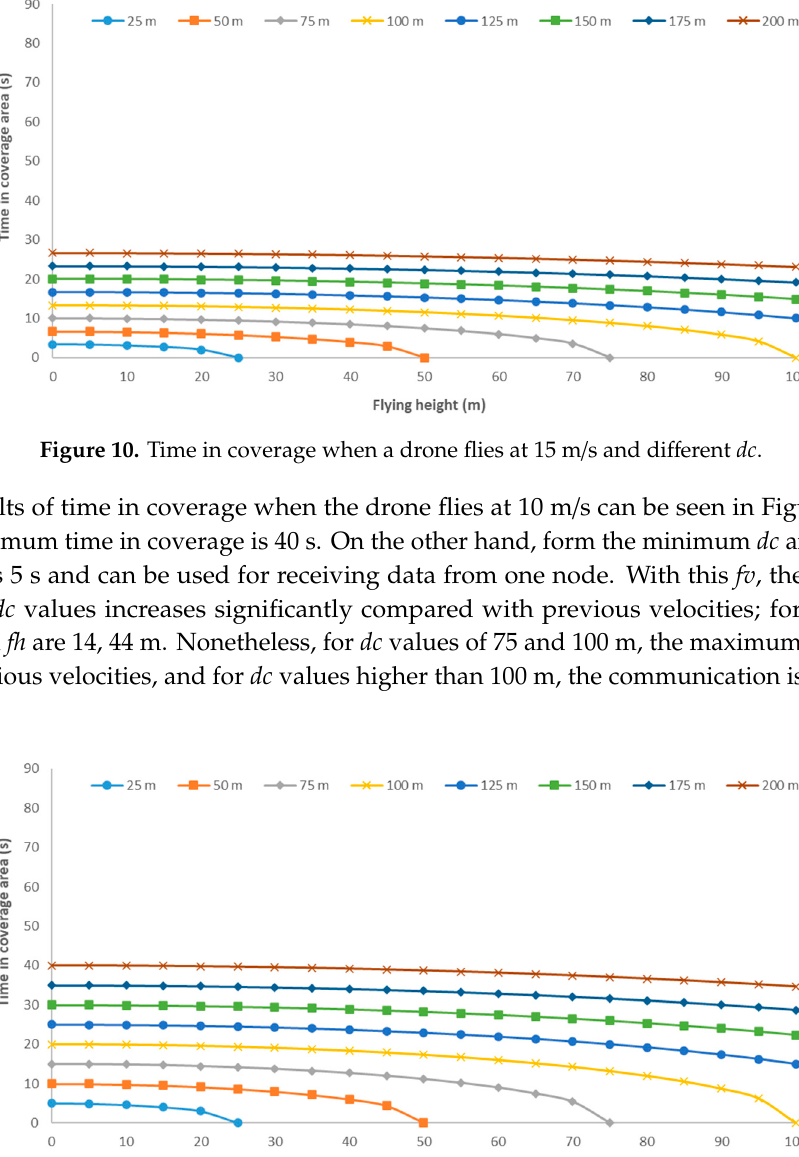
Figure 12. Time in coverage when a drone flies at 5 m/s and different dc .